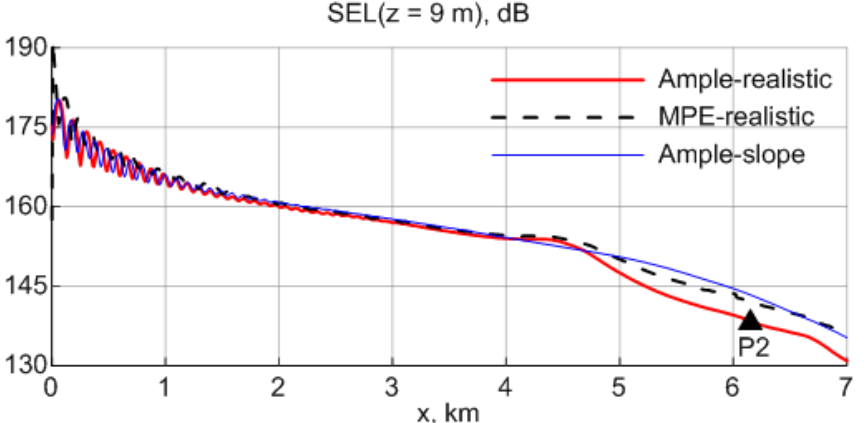
Figure 6. The dependence of the SEL on the range x at the depth of 9 m calculated by Ample and MPE for realistic and linear